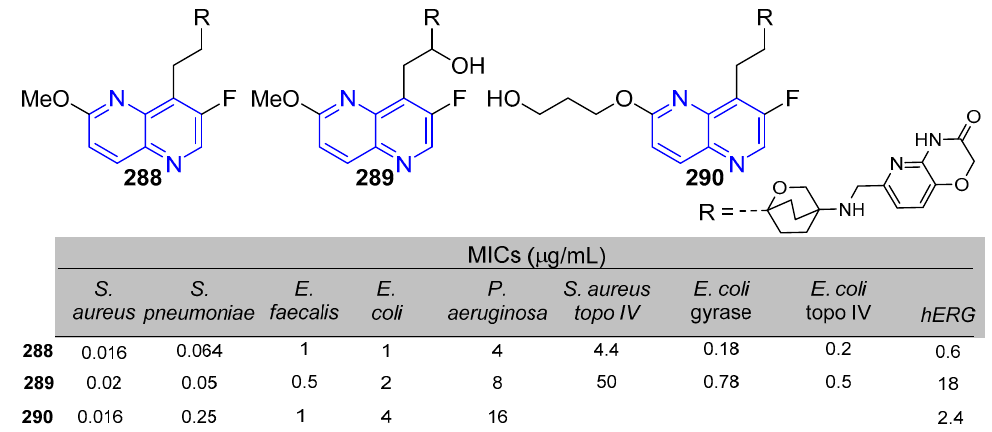
Figure 18. Broad-spectrum antibiotics containing a 1,5-naphthyridine core.